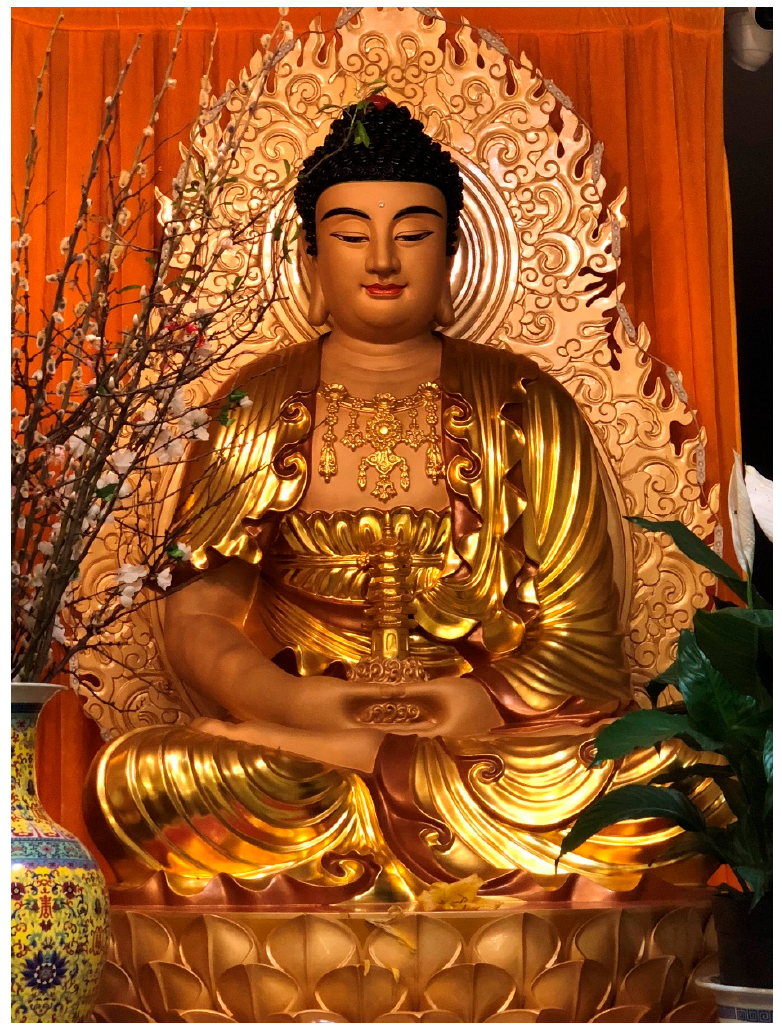
Figure 2. The “Medicine Buddha,” Bhai ṣ ajyaguru, at Fou Shou Si (Chinatown, Philadelphia). Source: www.jivaka.net.